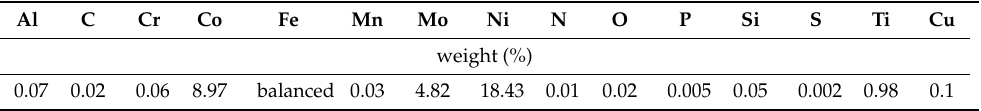
Table 1. M300 steel chemical composition.